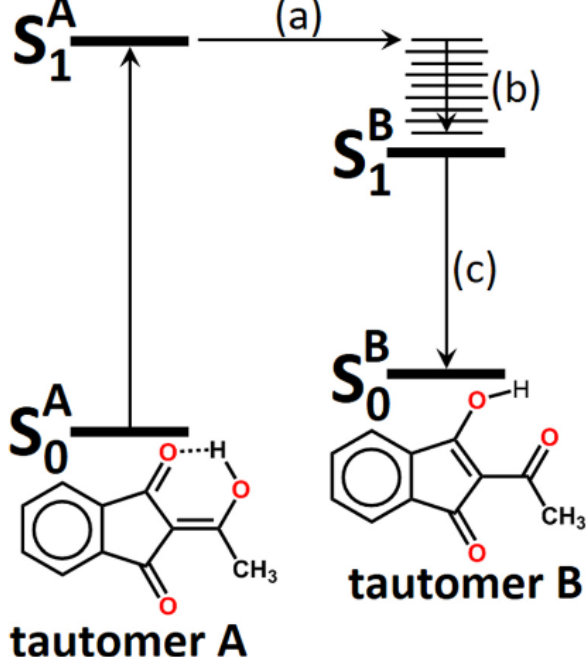
Figure 6. Enolic structure of 1,3-bis(4(10H-phenoxazin-10-yl)phenyl)3-hydroxyprop-2-en-1-one (PXZDO). Taken from Ref. [77] with permission from the American Chemical Society. A number of recent papers discuss fluorescence. An example is the modified bo- rondifluorid dipyrromethene (BODIPY), as seen in Figure 7. Solvent dependence was in- vestigated and for hydrogen bonding solvents interactions were found in the excited state between the OH group and the solvent [78]. The structure of DPHND (Figure 8) is held planar by the extra hydrogen bond. The molecular planarity is important for the genera- tion of highly emissive crystals [79,80]. The hydrogen bond motif is akin to that of tetra- cycline [9]. A slightly different construction, alkene-linked 1,1 ′ -bi-2-naphthol- β -diketones, was also shown to be highly emissive [81].